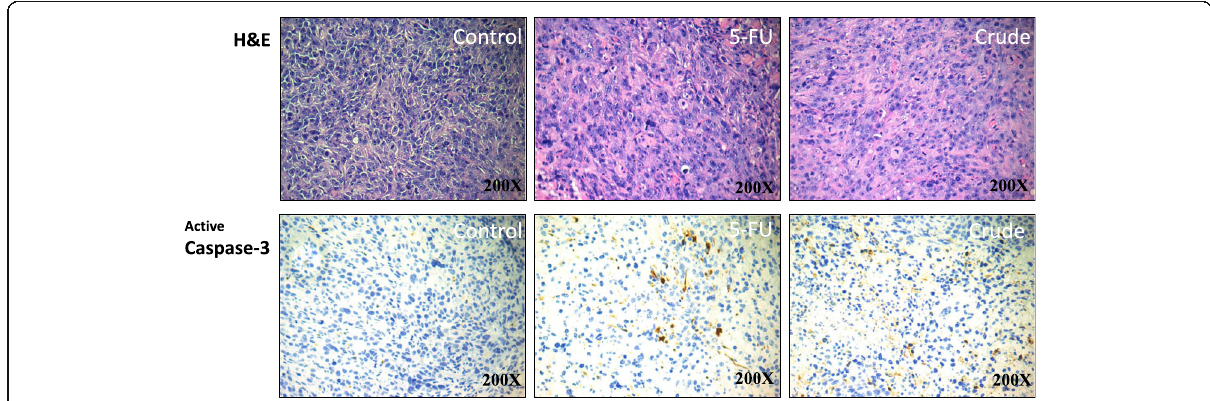
Fig. 6 Active caspase-3 expression induced in oral cancer cells in the SAS xenografts model using the Danshen crude. H&E staining and IHC were performed after administration of the Danshen crude, 5-FU, or PBS (a vehicle control). The SAS xenografts model stained active caspase-3. Immunodetectable proteins are stained brown and the nuclei are counterstained blue. Original magnification,